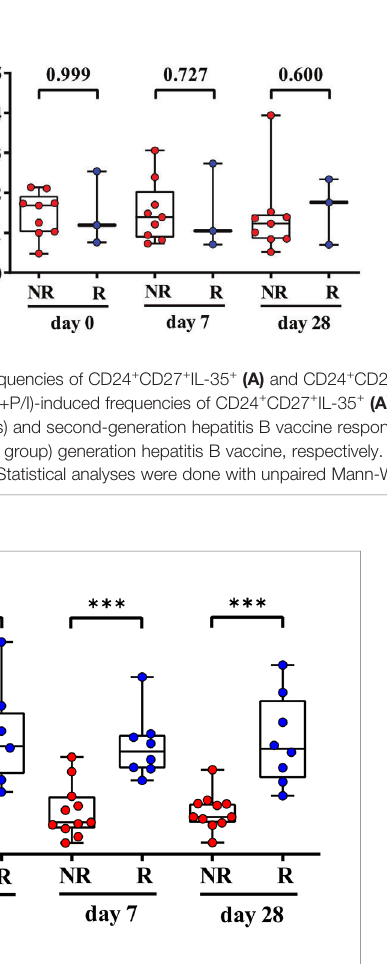
FIGURE 4 | Comparison of frequencies of CD19 + IL-10 + B (B10 + ) cells of second-generation hepatitis B vaccine non-responders and responders. Depicted are frequencies of B10 + cells of second-generation hepatitis B vaccine non-responders (NR, red circles) and second-generation hepatitis B vaccine responders (R, blue circles) before (day 0) and 7, and 28 days after vaccination with a third- (NR group) or second- (R group) generation hepatitis B vaccine, respectively. The boxes show the median and the 25 th and 75 th percentile. Whiskers indicate the highest and lowest values. Statistical analyses are based either on unpaired Mann-Whitney U tests for the analysis of the NR vs . the R group or on Friedman tests with post Wilcoxon signed rank testing for analysis of the impact of third- and second-generation hepatitis B vaccines within the NR or R group. *** p < 0.001; **** p <